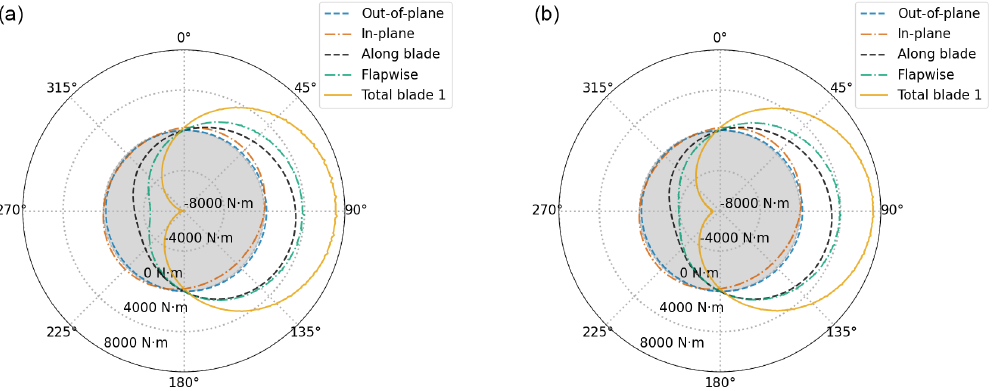
Figure 4. Individual blade 1 load contributions (out-of-plane in dashed blue, in-plane in dashed–dotted orange, along blade in dashed black and flapwise in dashed–dotted green) to the yaw moment (solid yellow) at tower top with respect to azimuth (20ms − 1 uniform wind speed) with (a) and without (b) tilt.